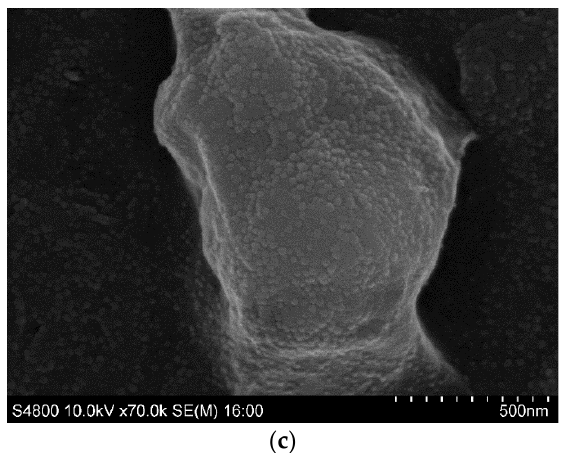
Figure 2. SEM images of ( a ) Mt, ( b ) nZVI particles, and ( c ) Mt-nZVI. The image of Mt-nZVI was taken at FZM = 0.66 g g −1 .